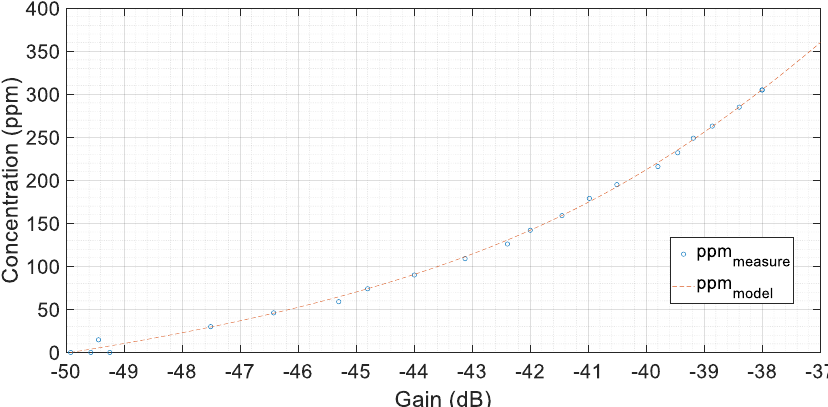
Figure 15. FRA tests for a transformer with distillated water core with salt. Tests compare distilled water and water with 305 ppm of salt.